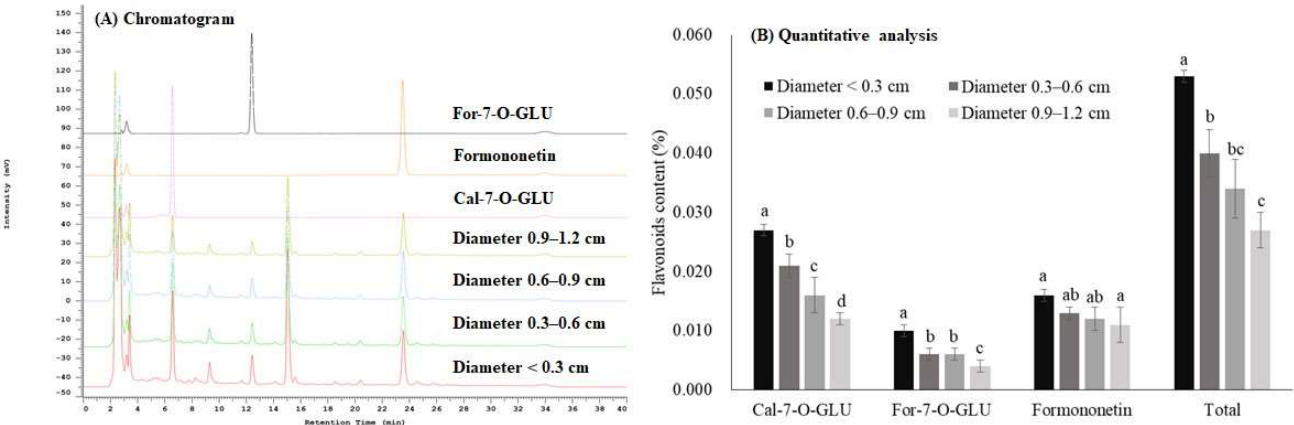
Figure 2. Effects of different diameters on the content of flavonoids in Astragali radix (AR). ( A ) HPLC chromatogram of standard solution (individual flavonoid) and test solution (different diameter sizes). ( B ) Quantitative analysis of flavonoids content with different diameter sizes. Data are expressed as mean ± SD from three separate experiments; means not sharing an alphabetic letter (lowercase for Cal-7-O-GLU, uppercase for For-7-O-GLU, italic lowercase for formononetin, and italic uppercase for total flavonoids) differ statistically ( p < 0.05). Total flavonoids is the sum of Cal-7-O-GLU, For-7-O-GLU, and formononetin. Abbreviations (alphabetically): Cal-7-O-GLU, Calycosin-7- O -β- D -glucopyranoside; For-7-O-GLU, Formononetin-7-O-glucoside.